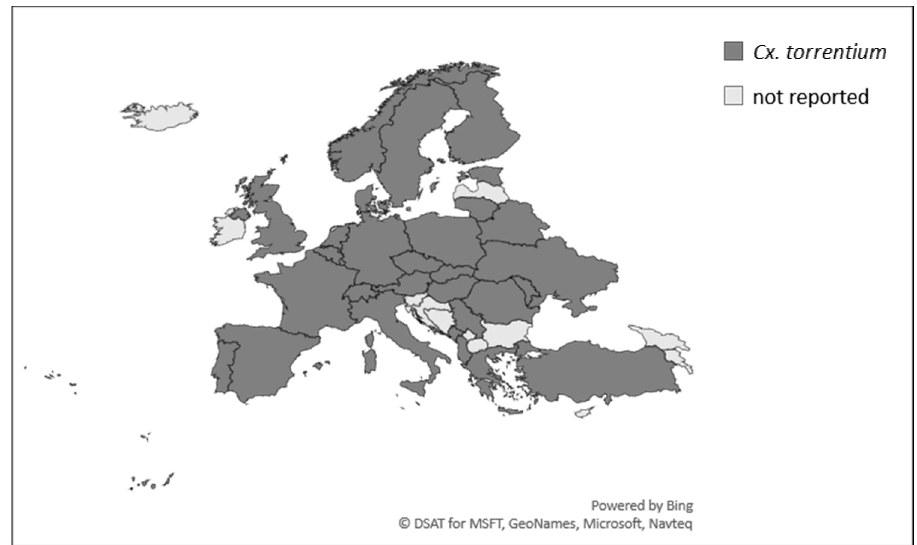
Figure 3. European country-level reports of Culex torrentium . References available in Appendix A.